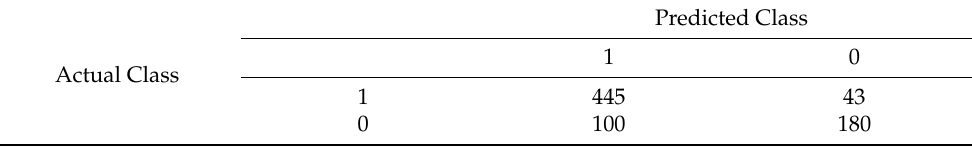
Table 7. Confusion matrix of CNN-LSTM.